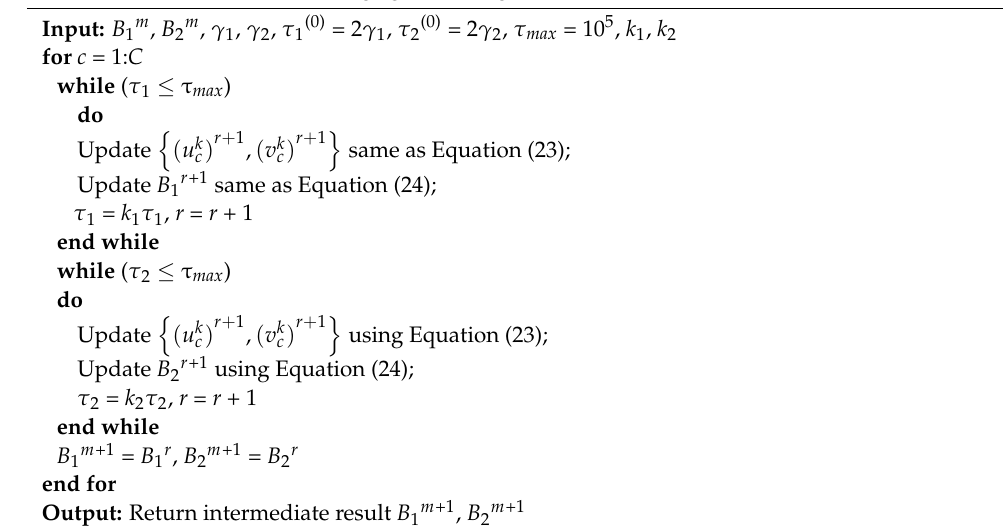
Algorithm 1 The l 0 -norm of image gradient algorithm